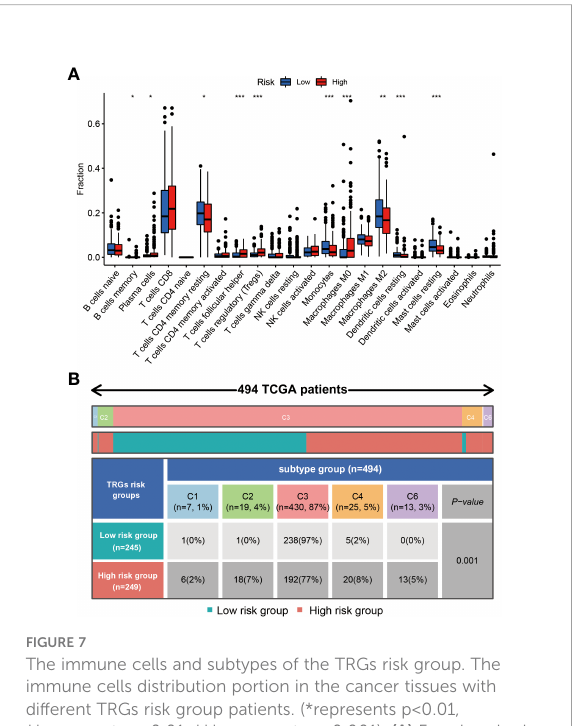
FIGURE 7 The immune cells and subtypes of the TRGs risk group. The immune cells distribution portion in the cancer tissues with different TRGs risk group patients. (*represents p<0.01, **represents p<0.01, *** represents p<0.001). (A) Four hundred of ninety-four patients in the total TCGA cohort has the immune subtype results, no C5 subtype in these patients, and C3 is the most common subtype in the two TRGs risk group. (B) .